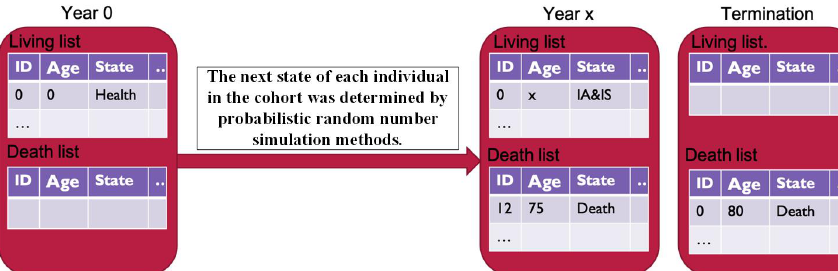
Figure 4. Flow of the whole